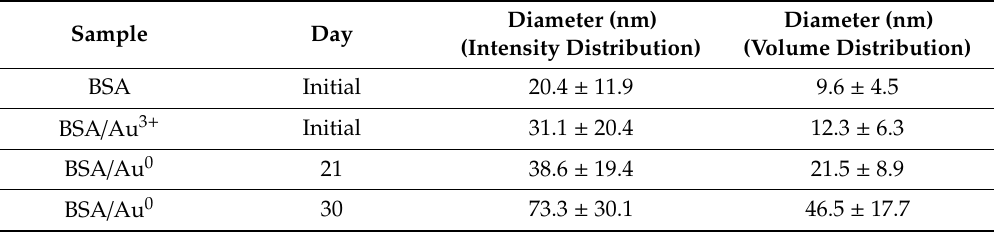
Table 1. Evolution of the average particle diameter in a solution of BSA (2 mg / mL) in the absence and presence of HAuCl 4 (10 − 3 M).